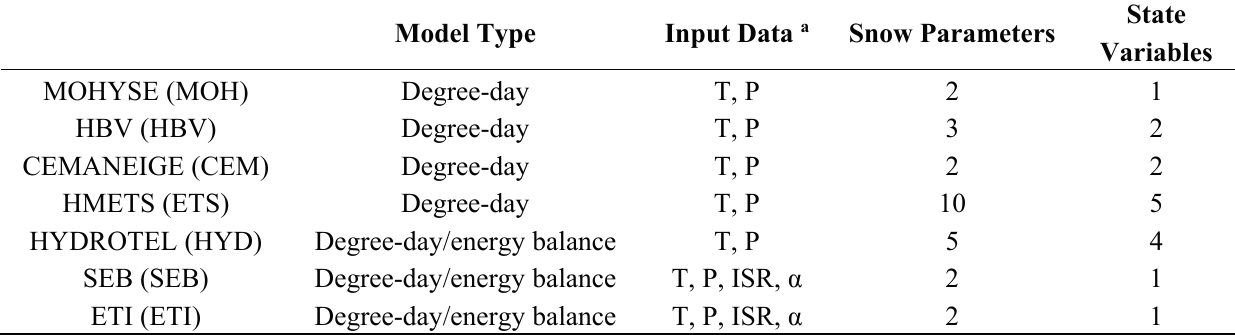
Table 2. Conceptual differences between the seven snow models. The acronyms of models used in this study are also